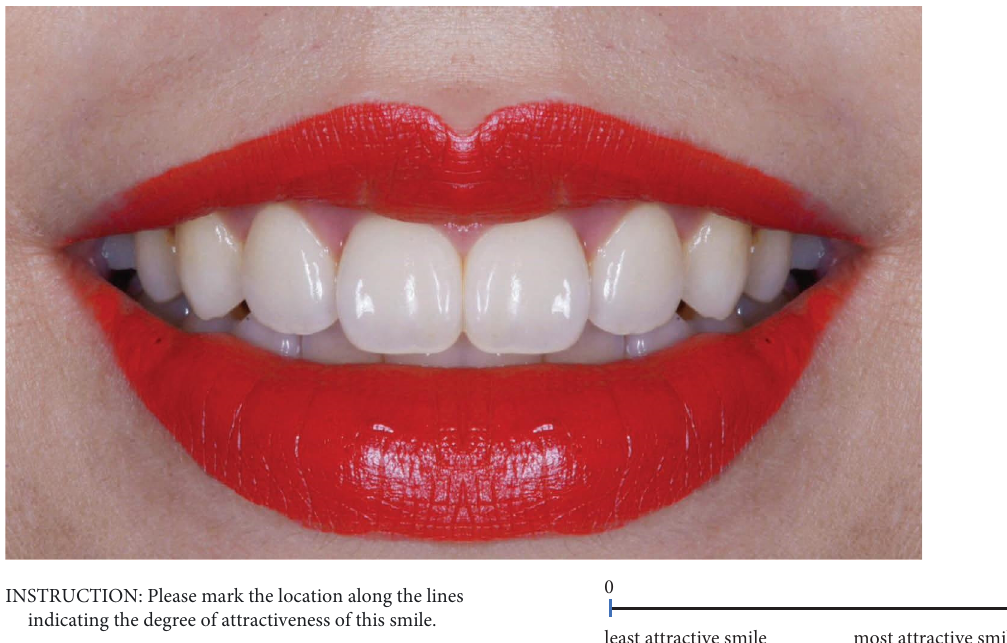
Figure 2: Example of a smile photograph on a page screen of the tablet scored using a 10 cm visual analog scale.